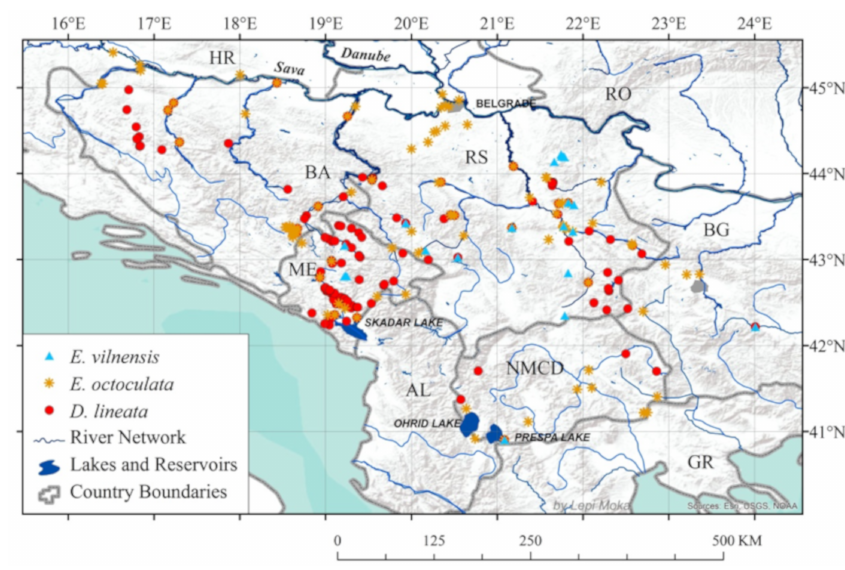
Figure 1. The distribution of E. octoculata , E. vilnensis and D. lineata, at analyzed sites.